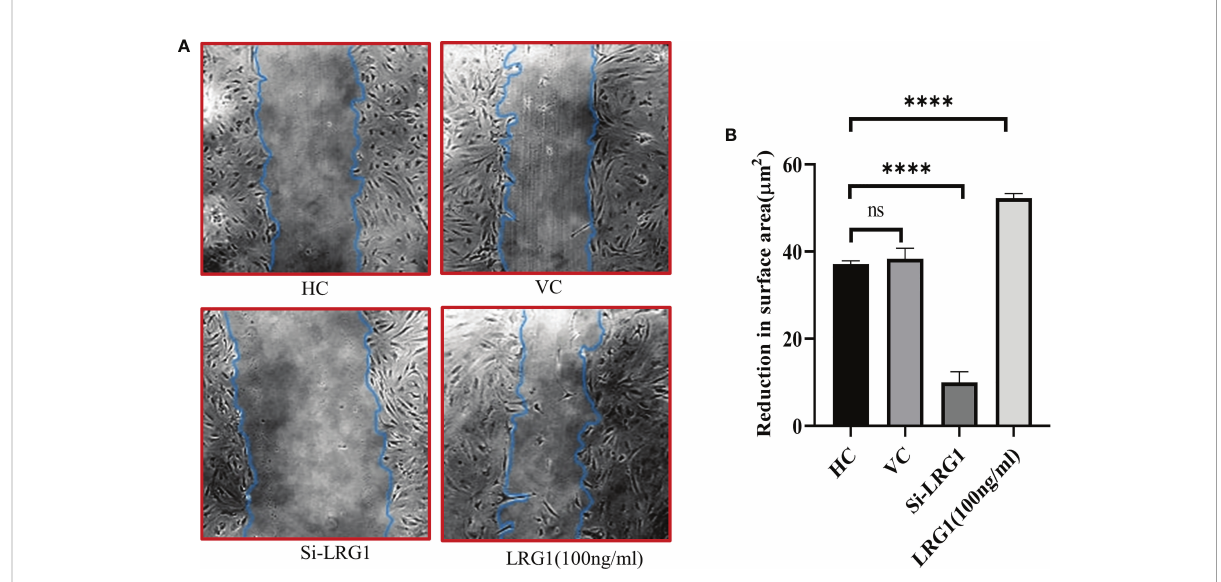
FIGURE 6 Wound healing and scratch assay. Microscopy images taken at ×10 magni fi cation using Nikon Eclipse 650 (NIKON, Tokyo, Japan). Analysis was carried out with ImageJ software using the freehand area selection tool. Graphs were generated and the statistical analysis carried out using GraphPad Prism (version 8.4.686). Data are presented as the mean ± standard deviation (SD). One-way ANOVA was used for comparisons of the data among groups to show statistical signi fi cance. (A) Wound healing and migration of primary synovial cells after stimulation with pure LRG1 (100 ng/ml) or knockdown with si-LRG1 (50 nM). (B) Graph showing wound healing of OA primary cells after knockdown with siRNA (50 nM) or stimulation with recombinant LRG1 as a function of reduction in the scratch surface area after 72 h of treatment. The results showed a 0.026- fold reduction in the wound healing capacity after knockdown, but a reverse effect was seen when the cells were stimulated with pure LRG1, which showed a 1.4-fold increased wound healing and migration compared to untreated cells. **** p ≤ 0.0001. ns , non-signi fi cant; LRG1 , leucine-rich alpha-2 glycoprotein; OA ,